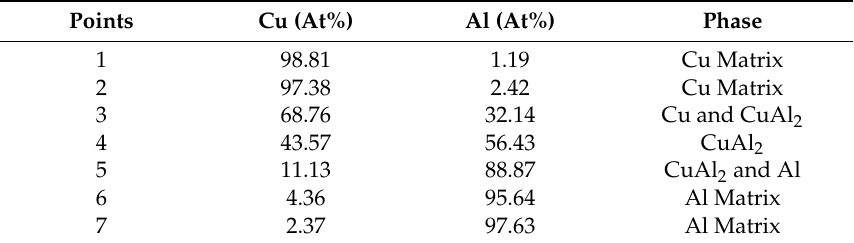
Table 1. Speculated phases of the interface in Cu/Al composite panels.